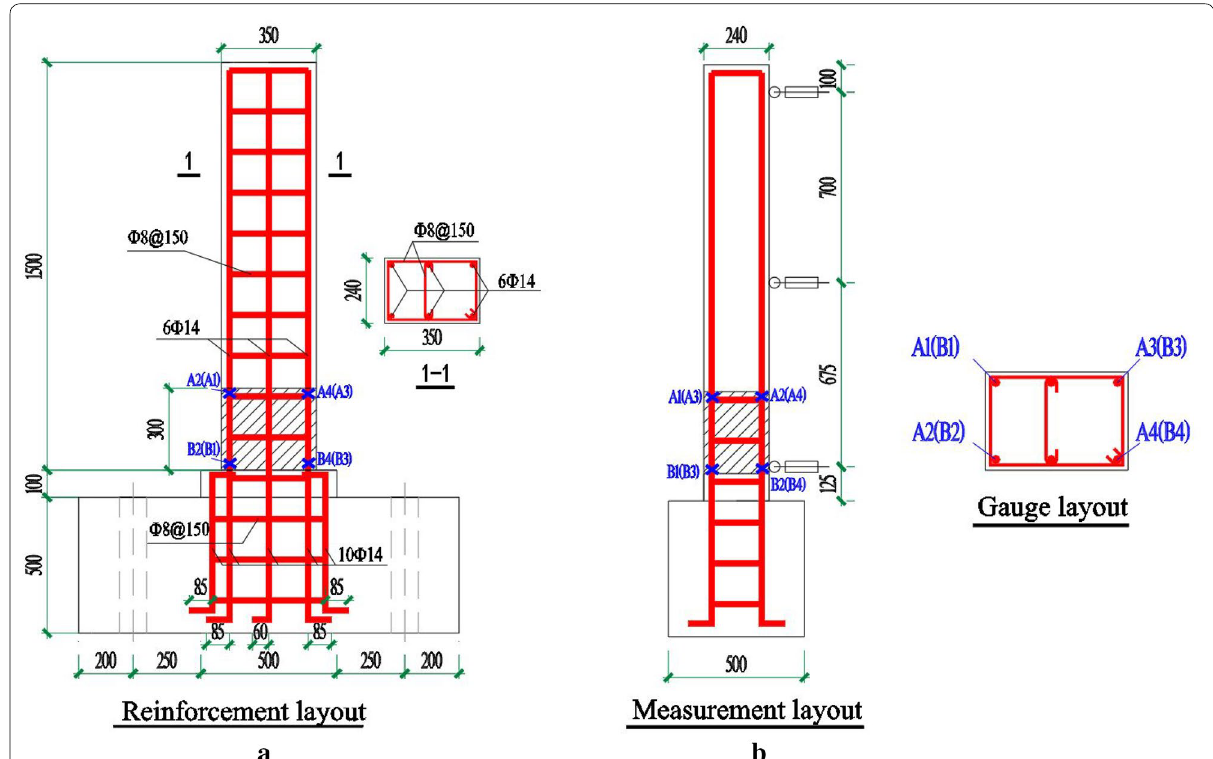
Fig. 4 Specimen design and measuring plan: a detailed design of tested specimens; b measuring plan.